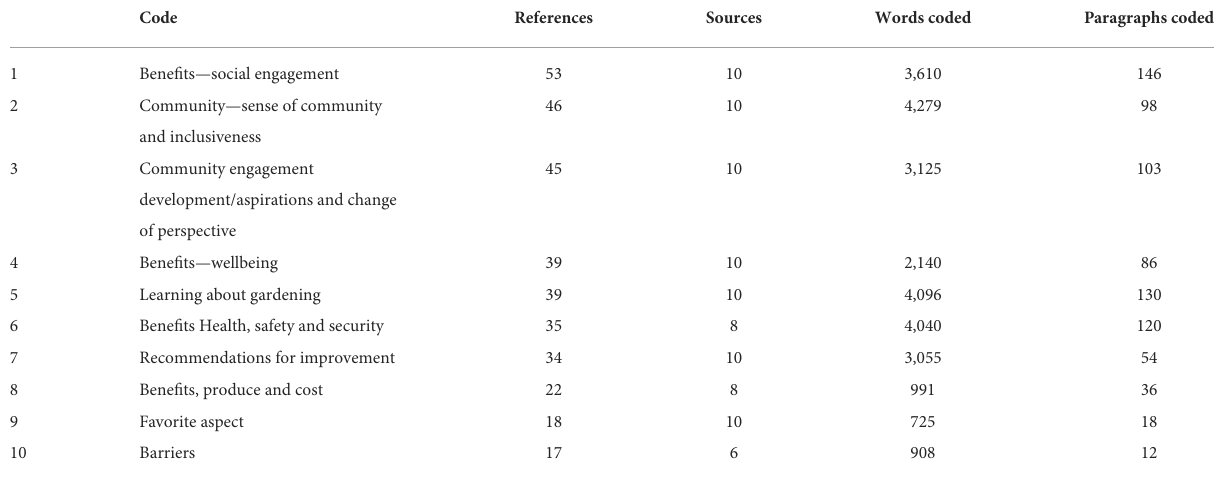
TABLE 1 Focus group codes, references and